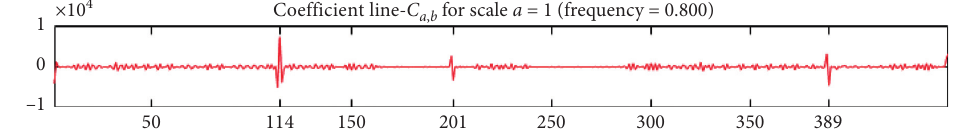
Figure 15: Wavelet coefficients of the frame structure.